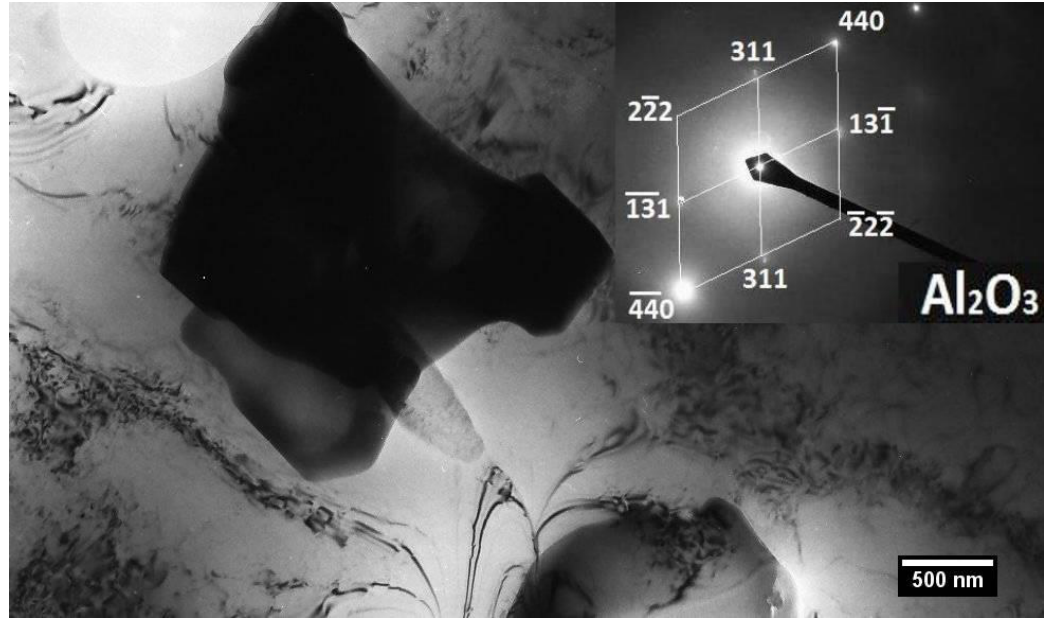
Figure 13. TEM image of the WM microstructure. Al 2 O 3 particles were identified by electron diffraction inside the inter-dendritic area.